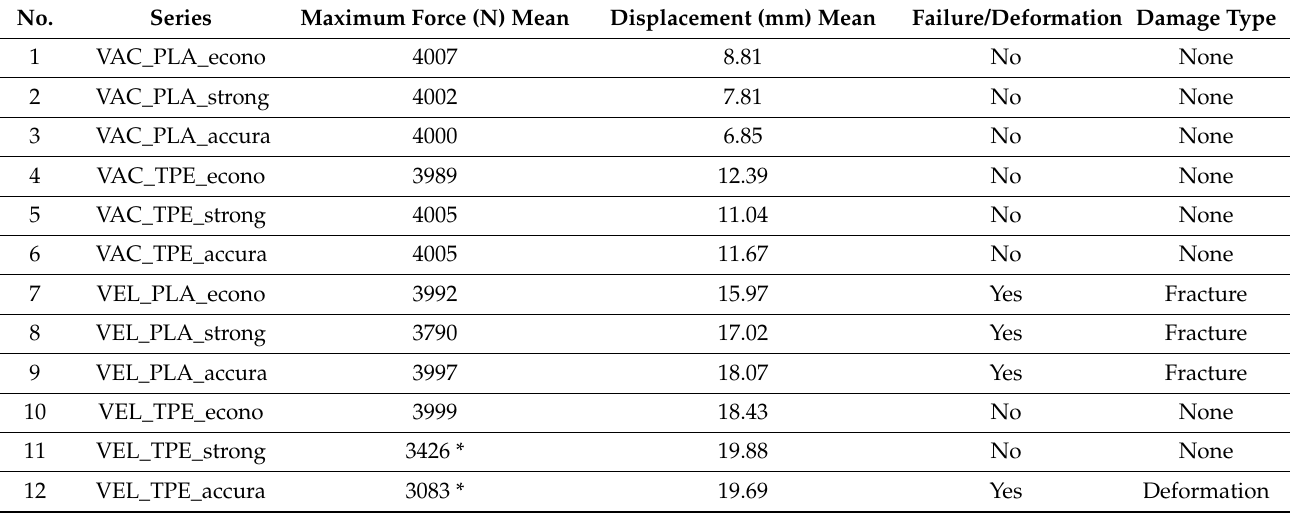
Table 4. Results of strength testing of the manufactured sockets.